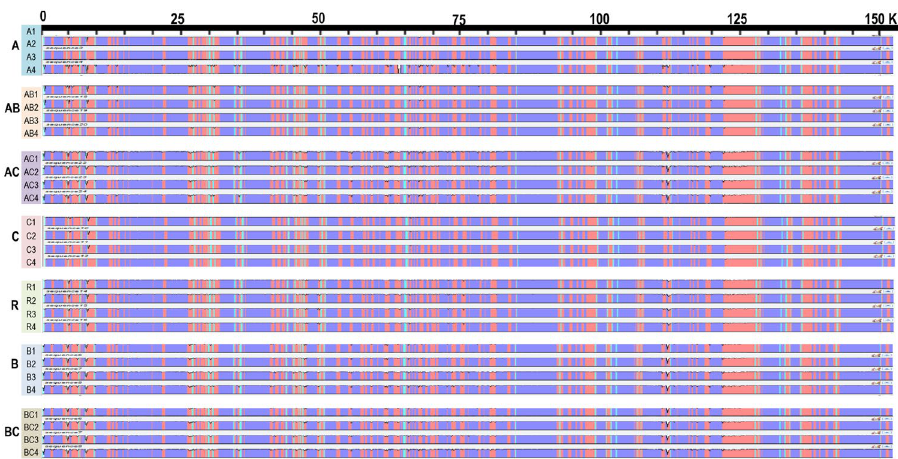
Figure 2. Comparative analysis based on complete chloroplast genomes identify similar and variable regions among the 28 Brassica and Raphanus genotypes.